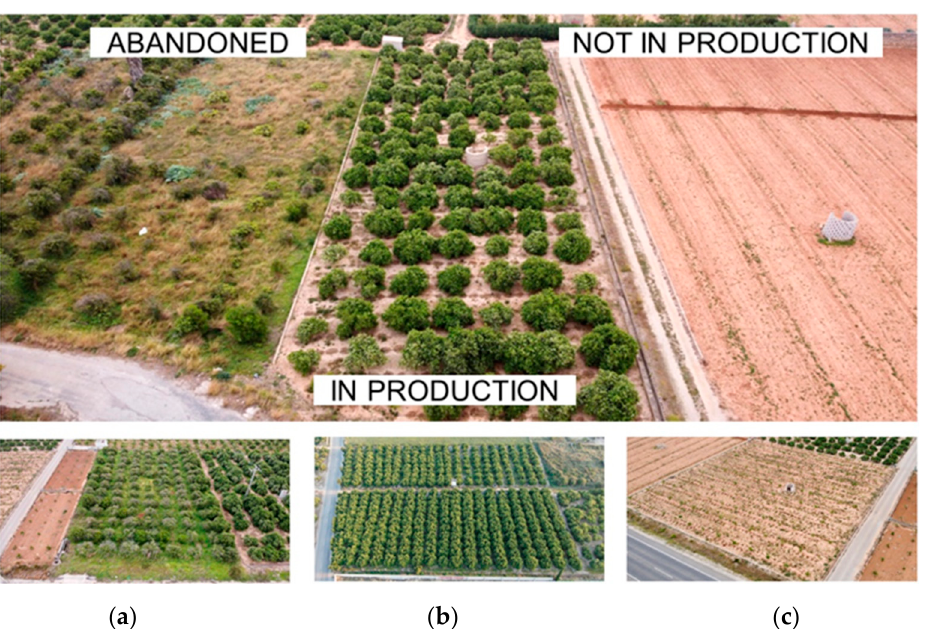
Figure 1. Aerial view of the three types of plots classified: ( a ) abandoned, ( b ) in production and ( c ) not in production.